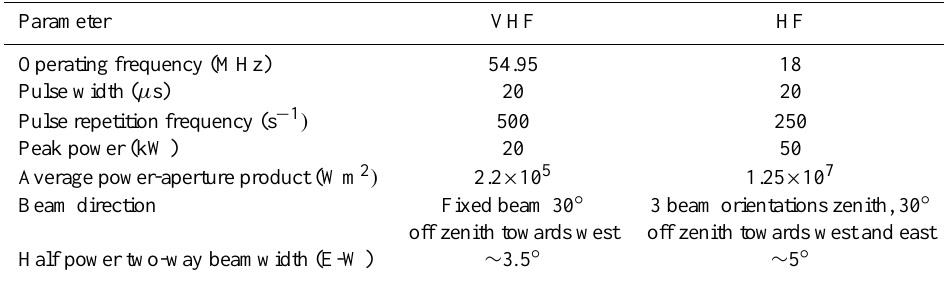
Table 1. Experimental specifications of VHF and HF radar systems at